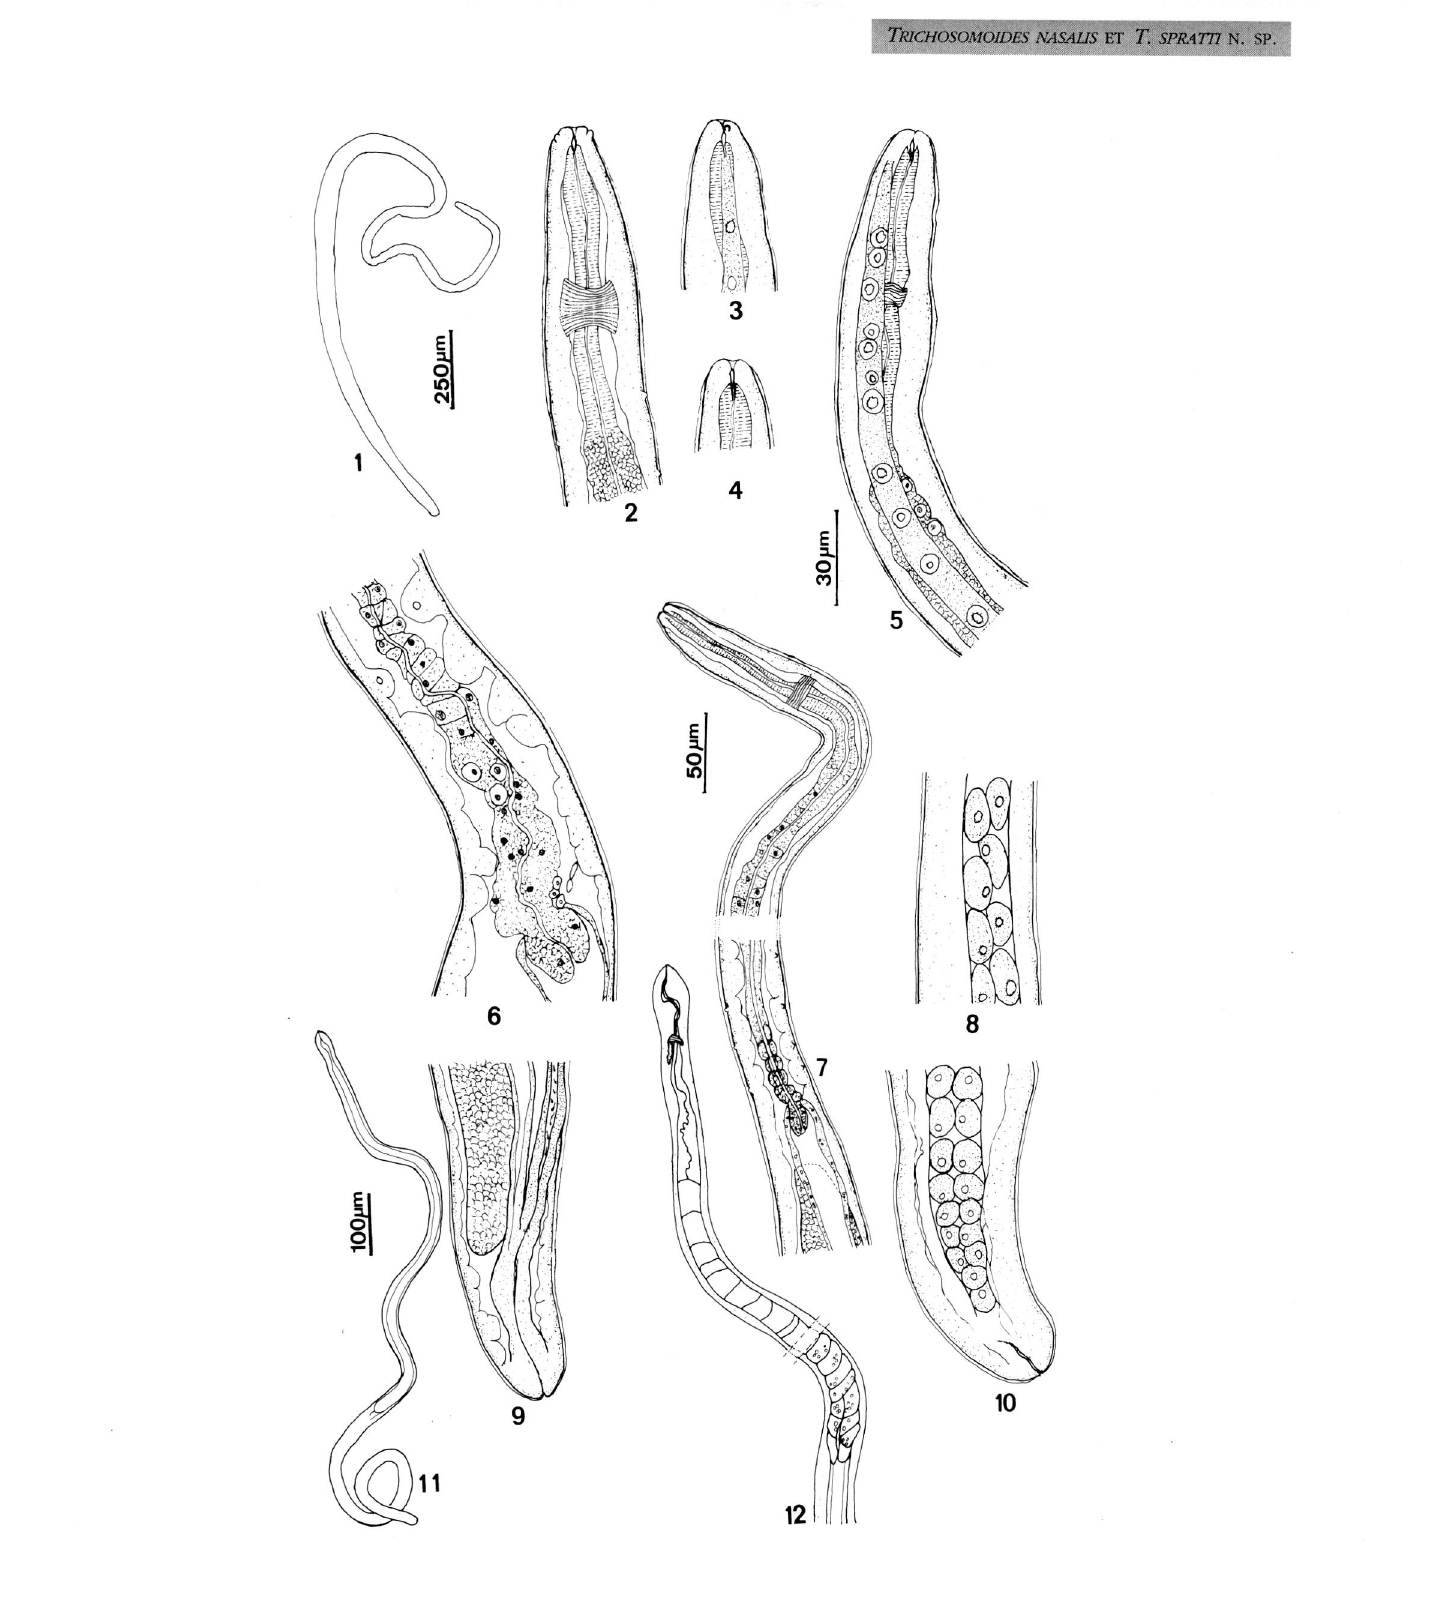
Fig. 1 à 10. - Trichosomoides nasalis, mâle. 1 : silhouette; 2 : région antérieure; 3 et 4 : extrémité céphalique avec stylet et amphide, res- pectivement en vues latérale et médiane; 5 : une bande bacillaire (pores et noyaux sont représentés) et début du stichosome dans la région antérieure; 6 : région postérieure du stichosome (peu de stichocytes individualisés) et valvule oesophagienne chez un mâle; 7 : début et fin du stichosome chez un autre mâle aux stichocytes bien individualisés; 8 : une bande bacillaire à mi-corps ; 9 : extrémité postérieure en vue médiane, et arrivée dans le cloaque du canal éjaculateur et de l'intestin (situés respectivement à gauche et à droite par rapport au cloaque); 10 : idem, vue latérale, avec une bande bacillaire. 11 et 12 : larve récoltée sur le prélèvement d'oreille du rongeur, respective ment silhouette et région antérieure (en deux morceaux : avant et arrière de l'œsophage). Échelles : 1, 250 µm; 2, 3, 4, 5, 6, 8, 10, 30 µm; 7, 9, 12, 50 µm ; 11, 100 µm. Parasite, 2000, 7, 215-220 Mémoire